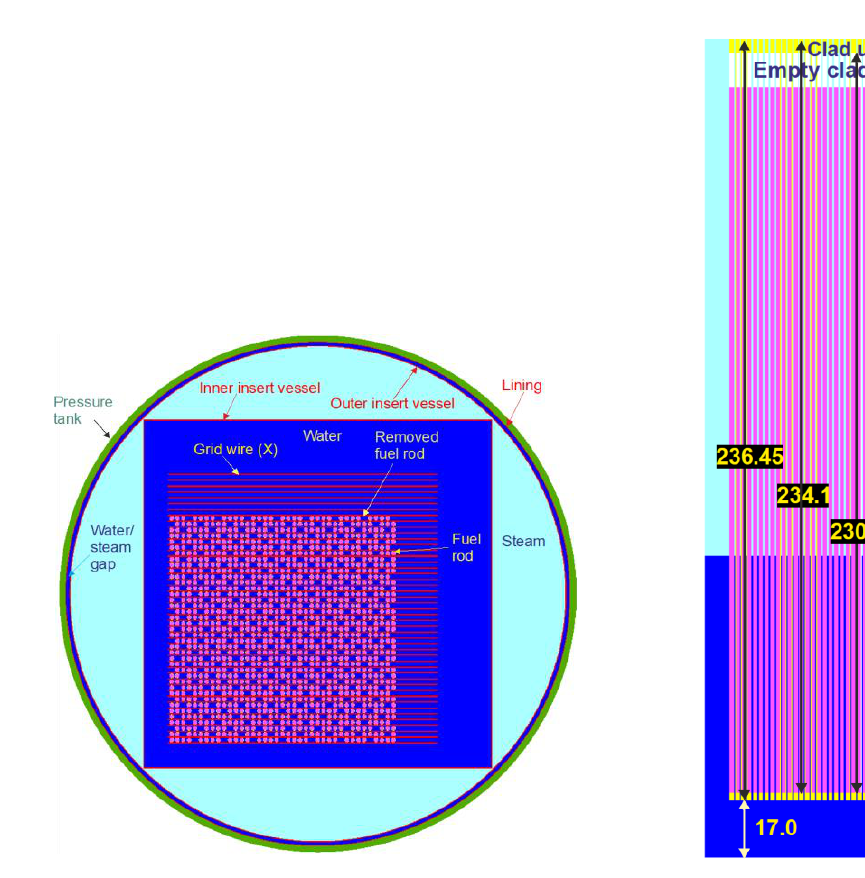
Figure 1(a). Detailed Model, Horizontal Cut. Figure 1(b) Simplified Model, Vertical